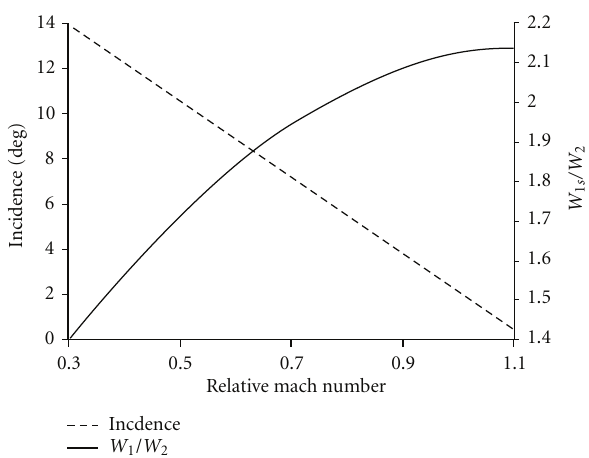
Figure 11: Stall incidence and relative velocity ratio versus Mach number.